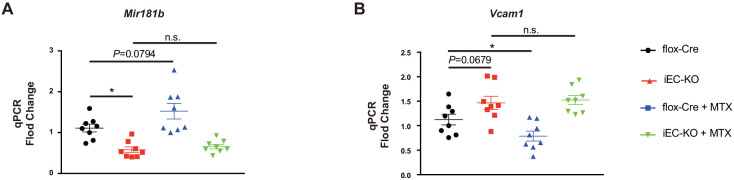
Breeding schema for creating endothelial-specific Mir181a2b2 KO mouse strain.(A) Real-time qPCR analysis of Mir181b expression in different tissues from Mir181a2b2flox/flox and Mir181a2b2—/— mice. (B) Schema showing strategy to generate endothelial Mir181a2b2 knockout mice using tamoxifen (4-hydroxytamoxifen (4-OHT)). (C) Four-week-old male Mir181a2b2flox/flox; VECad-Cre-ERT2 mice were injected i.p. with corn oil vehicle control or 4-hydroxytamoxifen (4-OHT, 10 mg/kg) for 5 consecutive days before tissue expression of Mir181b was assessed at day 14. (D–E) Mir181b expression in intima and aortic media/adventitia (D) or in skeletal muscle (SM) ECs and non-ECs (NECs) isolated by CD31 beads (E). (A), n = 1. D and E, n = 3. *p<0.05, ***p<0.001. All values represent mean ± SEM.